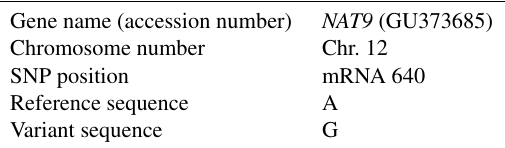
Table 1. Identification of SNPs in NAT9.